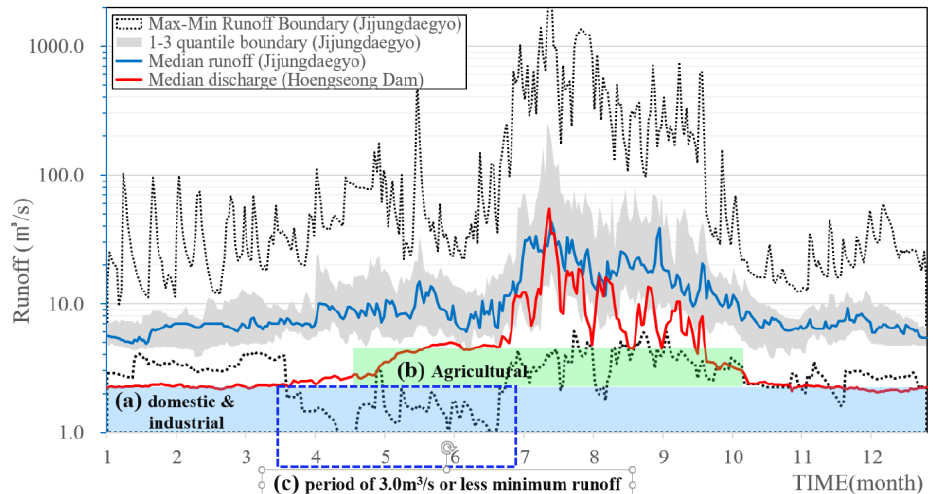
Figure 3. Flow diagram of Seom River basin for last 15 years; blue line indicates median runoff rate, red line indicates median discharge of the Hoengseong dam, dot-line indicates maximum to minimum runoff boundary, and gray-colored area indicates 1 to 3 quartile area of runoff, also ( a , b ) indicate discharged amount for domestic & industrial (blue box) and agricultural water (green-box) in the Hoengseong dam, ( c ) indicate the period of 3.0 m 3 /s or less minimum flow (blue dot-line box).